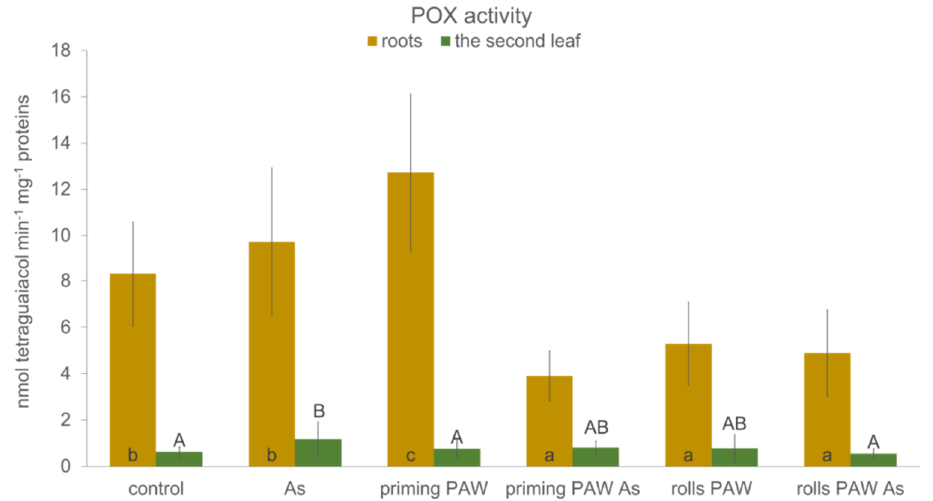
Figure 7. Activity of guaiacol peroxidase (G-POX, POX) of the maize roots and the second leaf